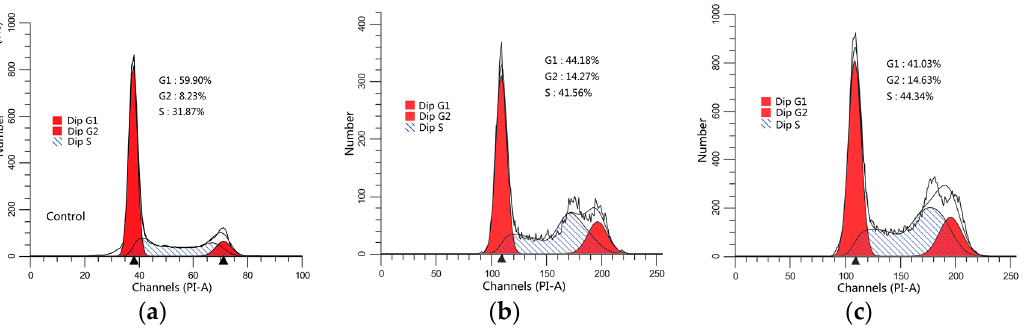
Figure 5. Cell cycle analysis of compound 4u by flow cytometry. ( a ) HeLa cells were not treated with 4u for 12 h; ( b , c ) HeLa cells were treated with compound 4u at 5 and 10 µM for 12 h, respectively. Table 3. Effects of compound 4u on cell cycle progression in HeLa cells.